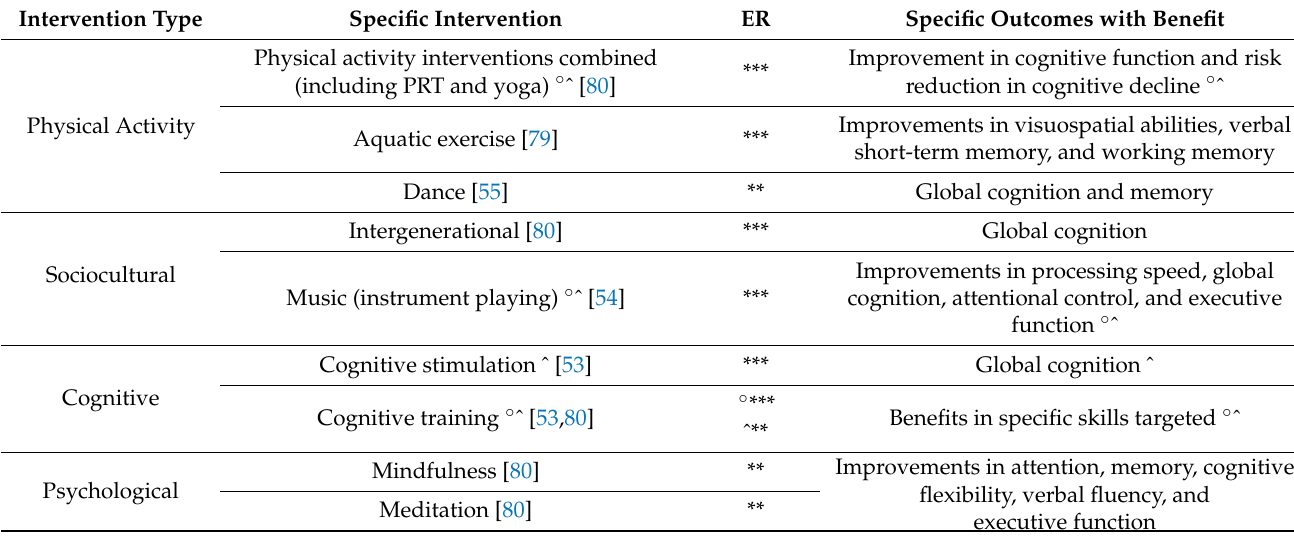
Table 3. Identified interventions for cognitive